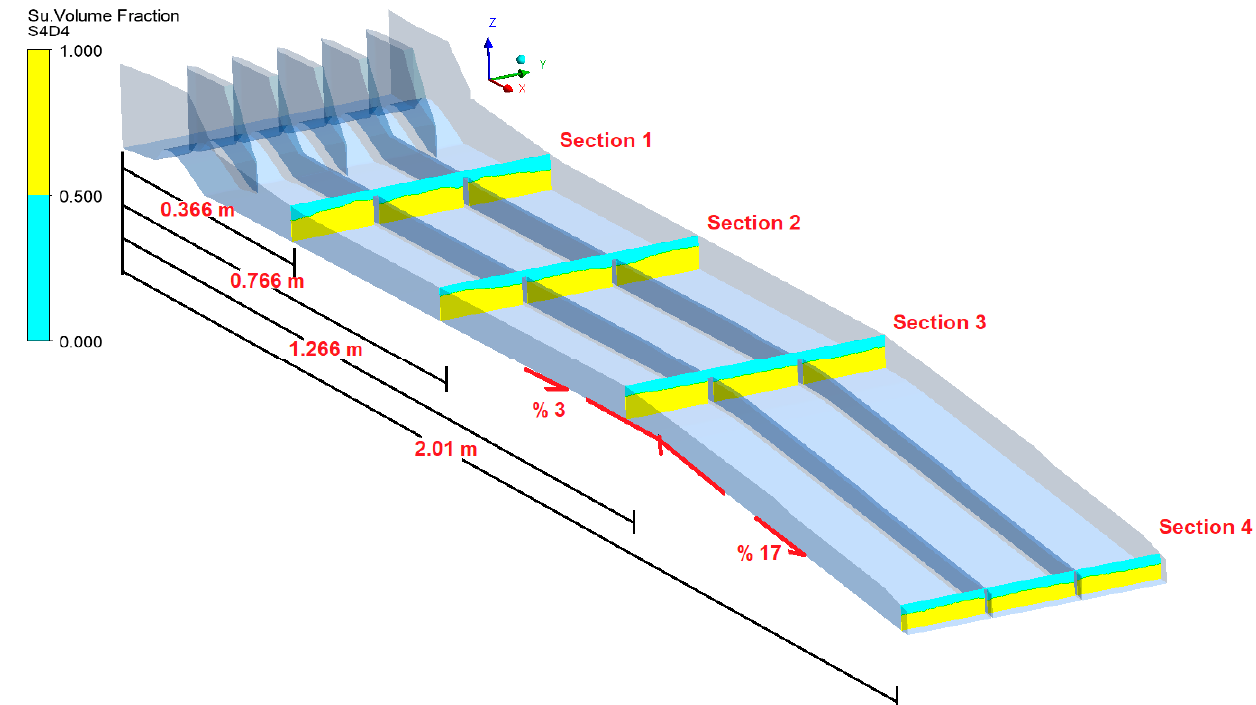
Figure 19. CFD analysis of water depths contours for four cross-sections.